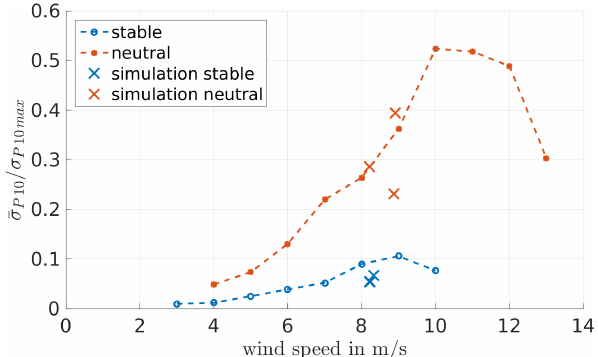
Figure 12. Normalised standard deviation of the power with re- spect to the wind speed determined from measurement data in com- parison to the simulation results ( × ). Sorted into stability by eddy- covariance data, TI and shear determined from the met mast data.